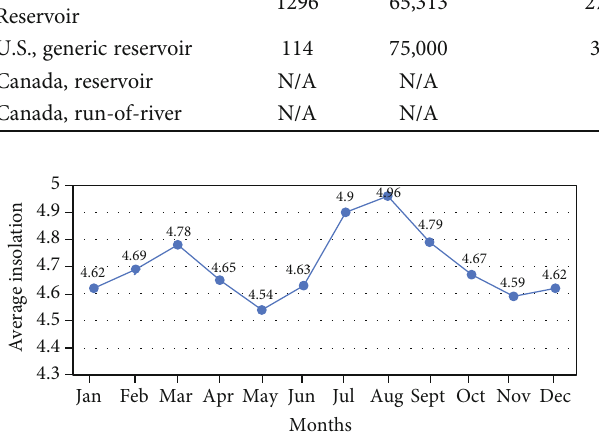
Figure 13: Rwanda monthly average solar insolation incident on a horizontal surface (kWh/m 2 /day). The data was collected from the National Administration of Aeronautics and Space (NASA),